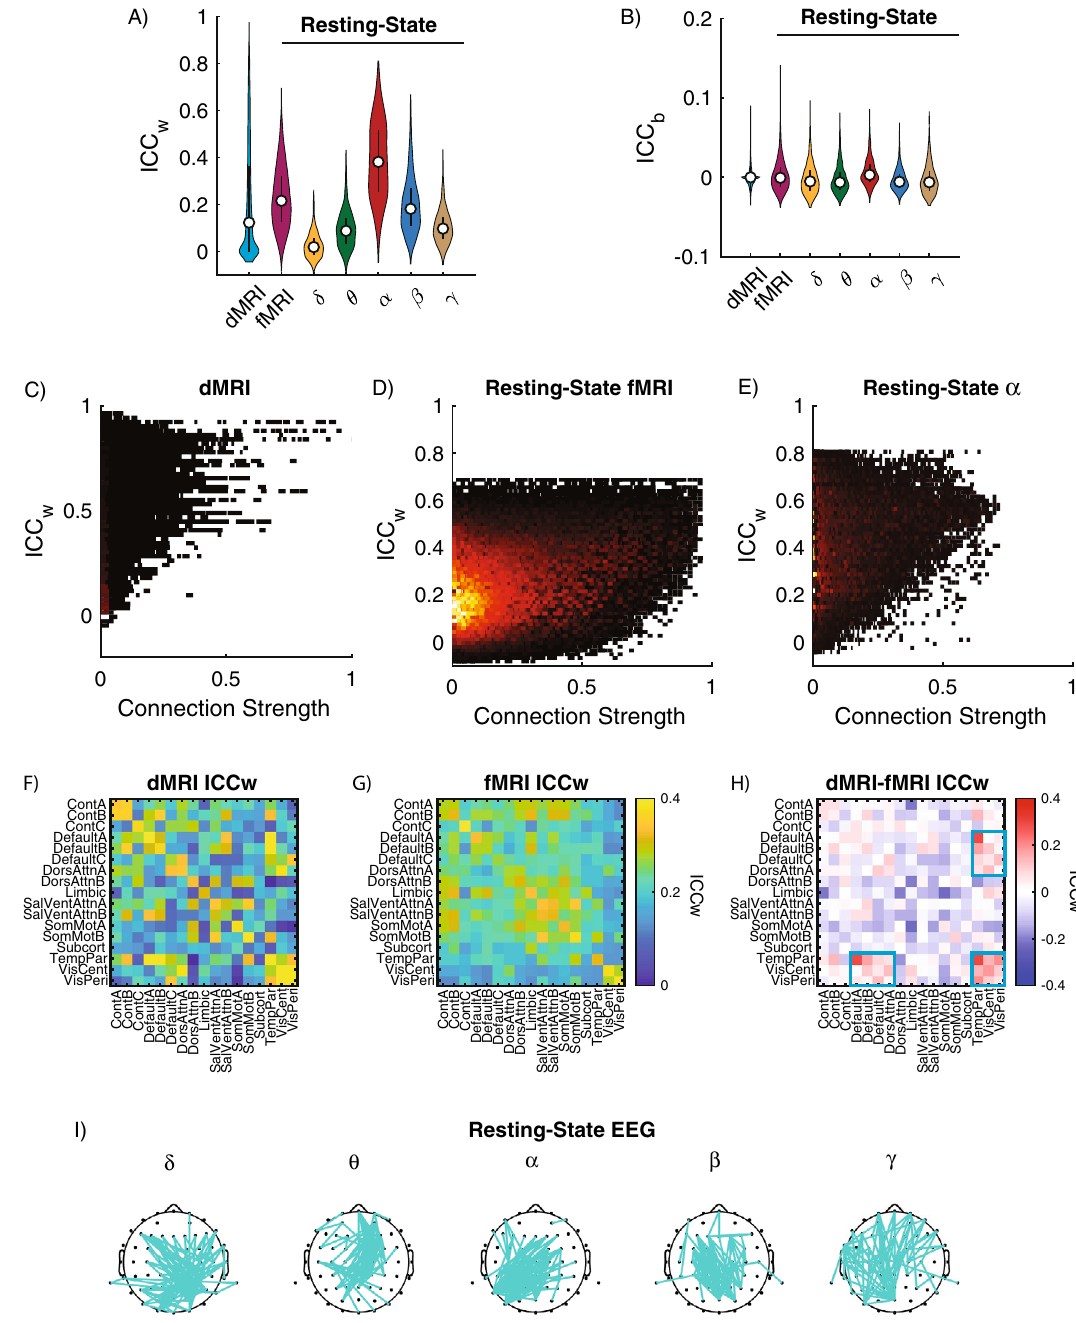
Figure 1. Reliability of individual connections. ( A ) Distribution of ICC w and ( B ) ICC b for dMRI and resting- state fMRI and EEG frequency bands. For each violin plot, the central dot indicates the median, and the line indicates the 25th–75th percentiles. ( C – E ) Distribution plots showing the connection strength of ICC w scores for ( C ) dMRI; ( D ) Resting-State fMRI and ( E ) EEG-α. ( F – H ) Average reliability of connection within and between cognitive systems for ( F ) dMRI and ( G ) resting-state fMRI. ( H ) Differences in average ICC w scores across cognitive systems between dMRI minus the fMRI. Blue boxes highlight connections between cognitive systems in which reliability was stronger in dMRI. ( I ) Connections with ICC w scores in top 5% for δ, θ, α, β and γ frequency bands plotted on the scalp for resting-state EEG. Cognitive systems are defined as Cont: Control A/B/C, Default: Default Mode A/B/C, DorsAttn: Dorsal Attention A/B, Limbic, SalVentAtt: Salience/Ventral Attention A/B, SomMot: Somatomotor A/B, Subcortical, TempPar: Temporal Parietal, VisCent: Visual Central, VisPer: Visual